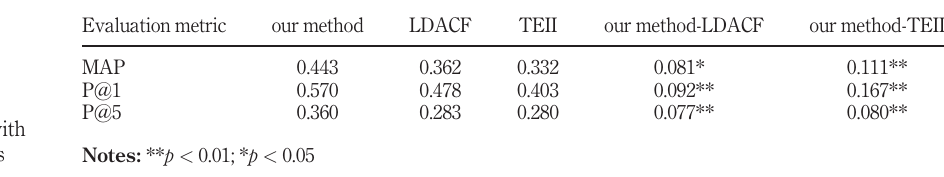
comparison with other